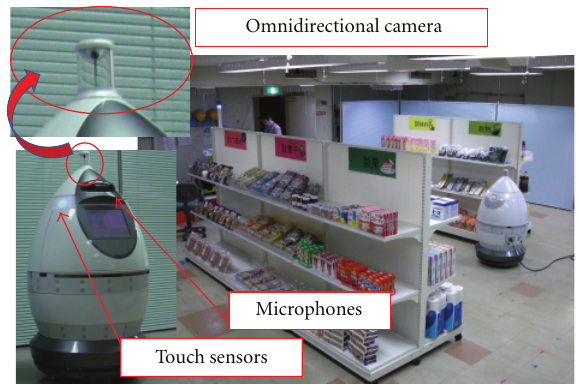
Figure 5: ApriTau and experimental